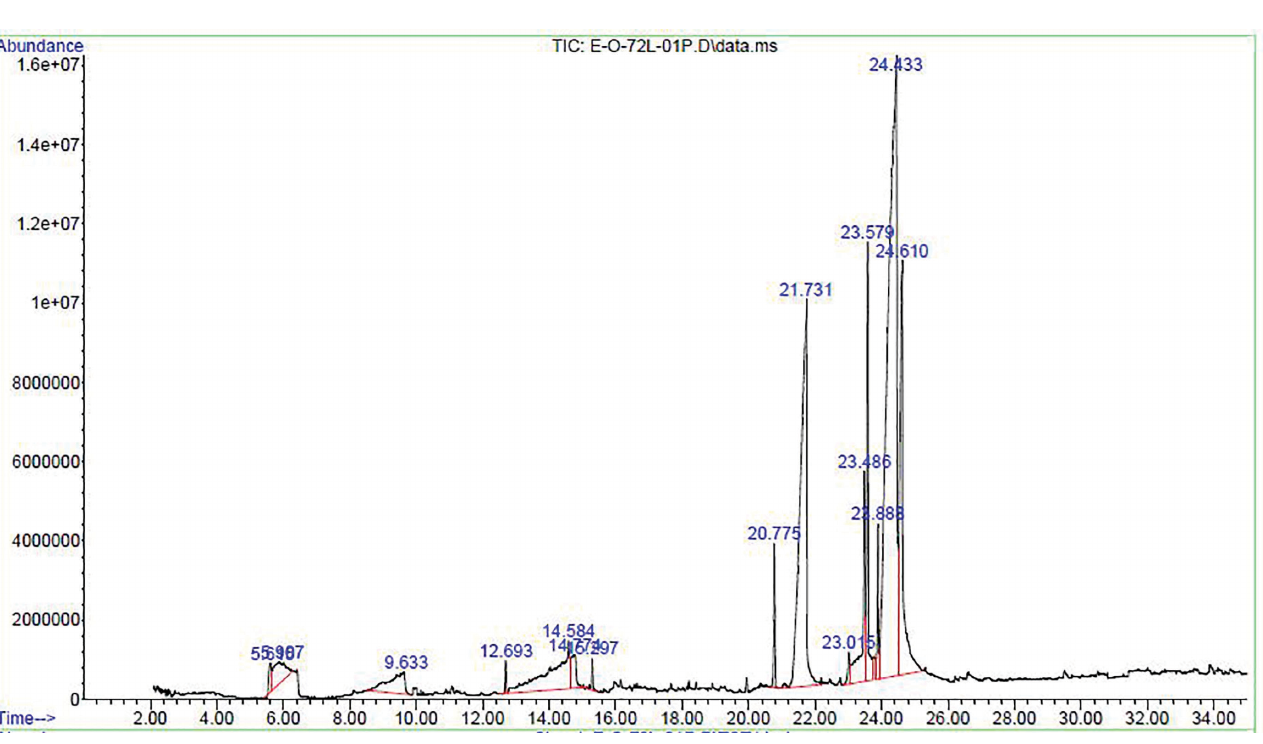
FIGURE 2 - Gas Chromatography Mass Spectrum of stem extract of S.oblonga.